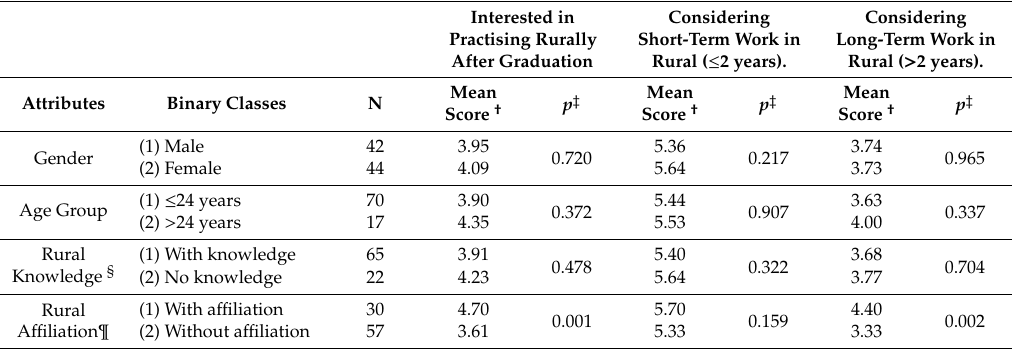
Interested in Considering Considering Practising Rurally Short-Term Work in Long-Term Work in After Graduation Rural ( ≤ 2 years). Rural ( > 2